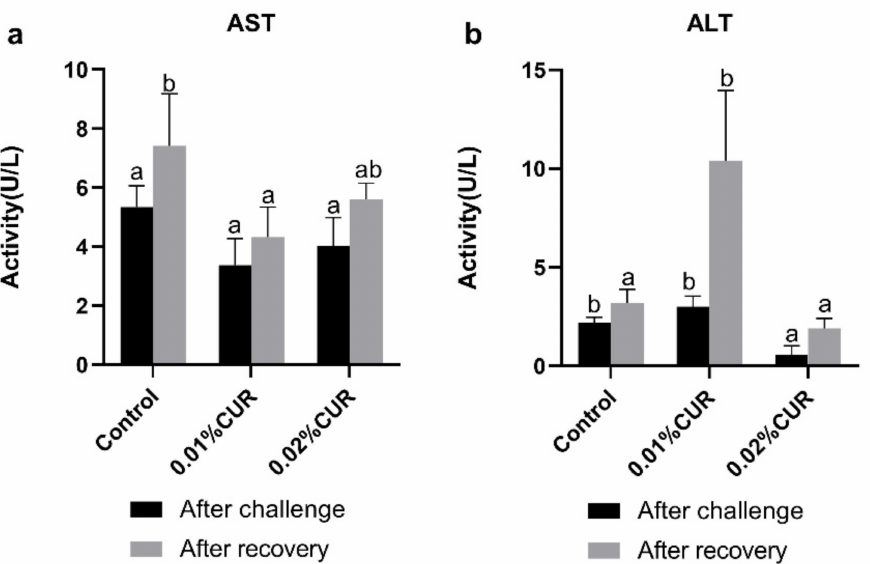
Figure 4. ( a ) Aspartate aminotransferase (AST) and ( b ) alanine aminotransferase (ALT) activities of greater amberjack fed with dietary curcumin supplementation. (Different letters above bars indicate significant differences at the 0.05 level).